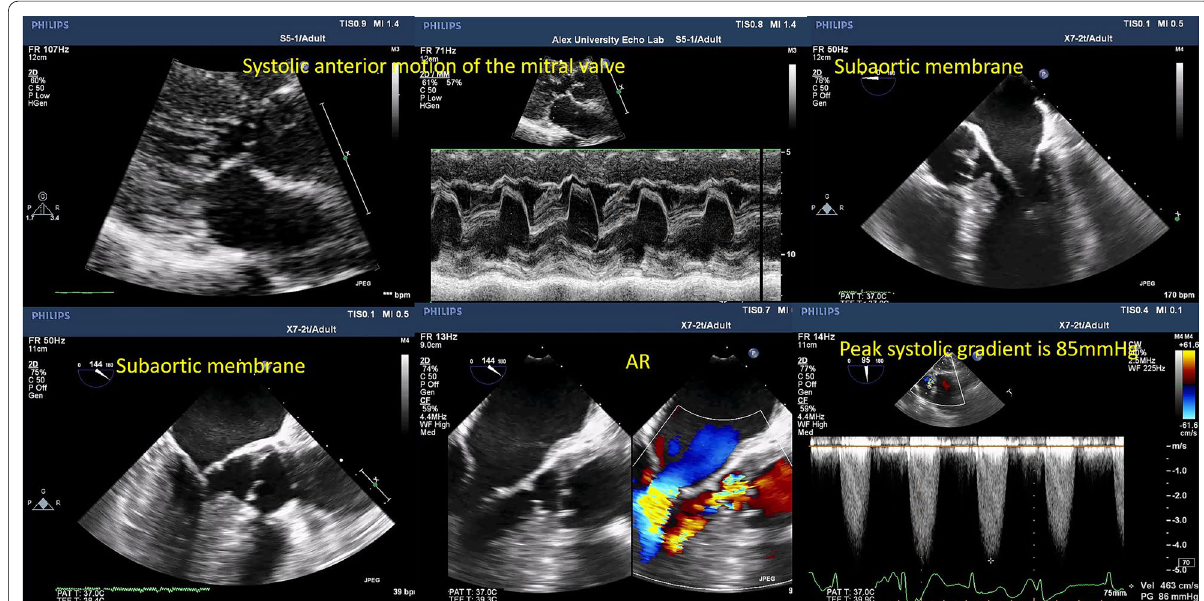
Fig. 10 A right upper and middle panels, parasternal long‑axis view, and M‑mode show left ventricular hypertrophy and systolic anterior motion of the mitral valve. 2D TOE (left upper and right lower and middle panels) shows a subaortic membrane and aortic valve regurgitation. In the left lower panel, high peak and mean transaortic